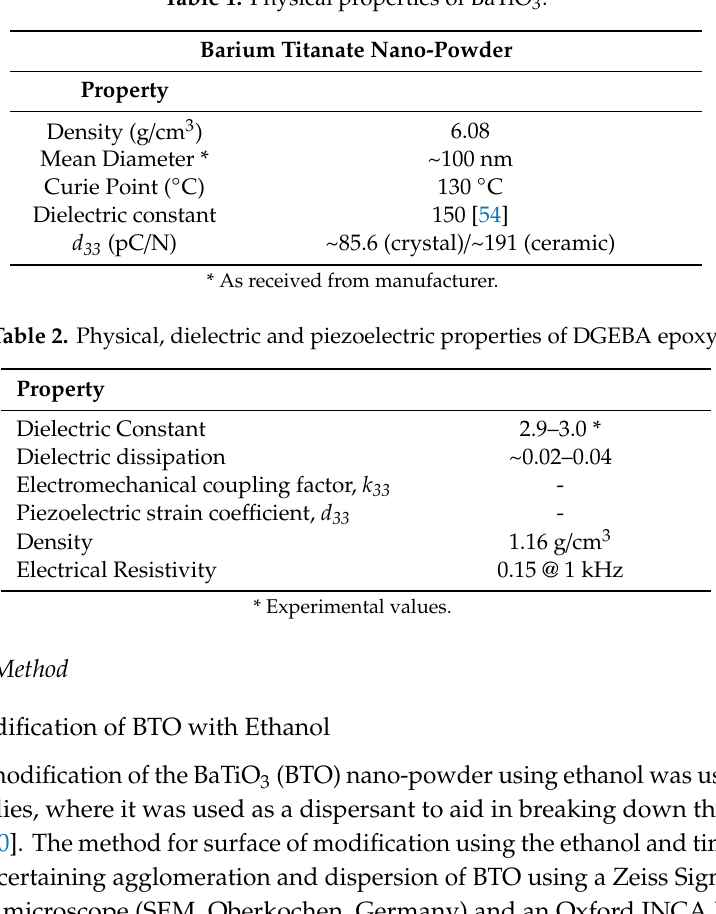
Table 1. Physical properties of BaTiO 3 .